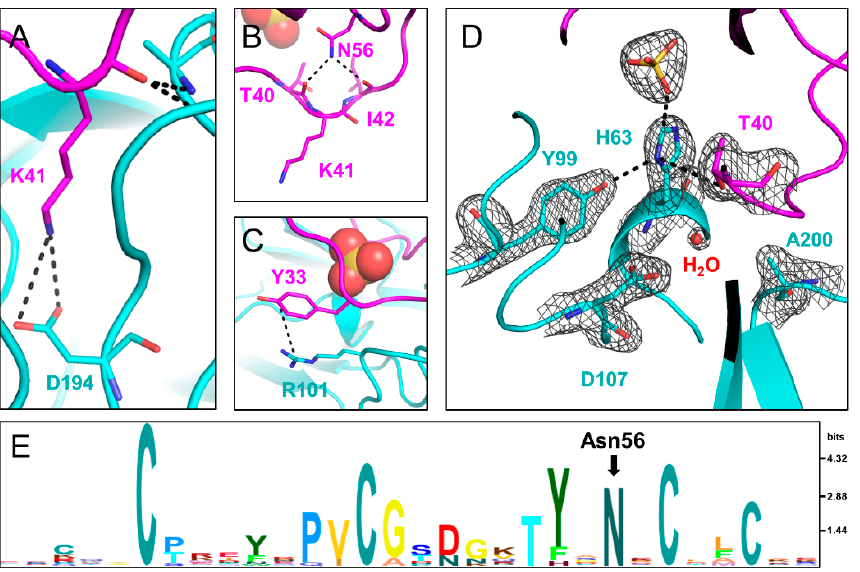
Figure 3. Interactions between TRY1 p.S200A (cyan) and SPINK1 p.N34S (pink). ( A ) Lys41 in SPINK1 interacts with the specificity determining Asp194 in TRY1. ( B ) Asn56 in SPINK1 stabilizes the binding loop by hydrogen bonding with Thr40 and Ile42. ( C ) Tyr33 in SPINK1 forms a cation—pi bond with Arg101 in TRY1 and is hence pulled outward. ( D ) Catalytic triad of the TRY1 p.S200A–SPINK1 complex (cyan). The 2Fo–Fc density map is shown at 1.6 Å around the residues of the catalytic triad and is contoured at 1.5 σ . In the complex structure His63 is rotated toward the sulfate ion and out of the productive catalytic triad arrangement. ( E ) Sequence conservation of the Kazal 1 family displayed by an HMM logo generated in Skylign [35]. Amino acid letter height is calculated based on the information content above background expressed in bits.